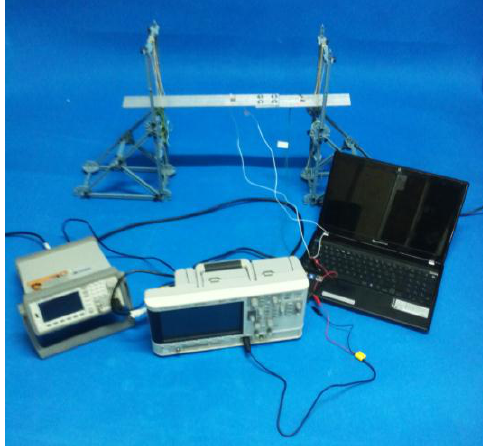
Figure 4. Experimental setup for guided waves measurements on the bolt-jointed aluminium beam.